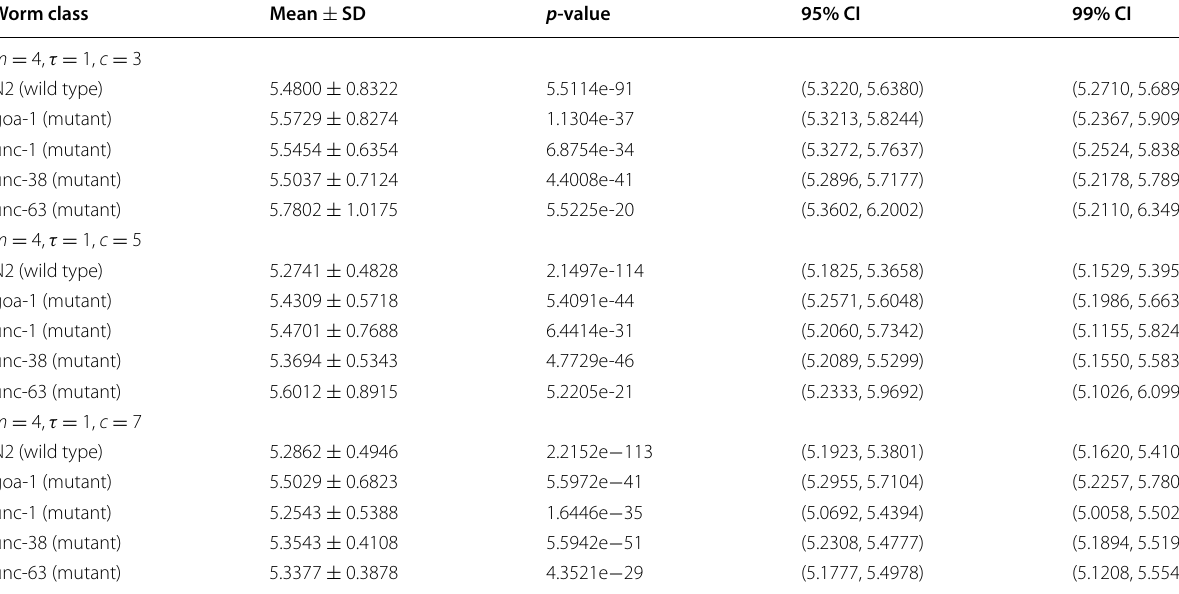
Table 3 Average largest eigenvalues and confidence intervals of eigenworm recurrence behavior Worm class Mean SD p -value ±